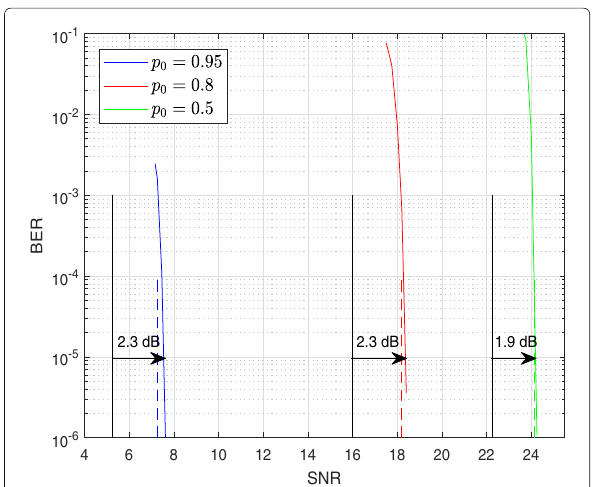
the BER vs SNR curves obtained by Monte Carlo simula- tions, as well as the theoretical decoding thresholds for the designed codes (shown as vertical dashed lines), and the corresponding Shannon limits (vertical black lines). Note from the Monte Carlo simulations that the code